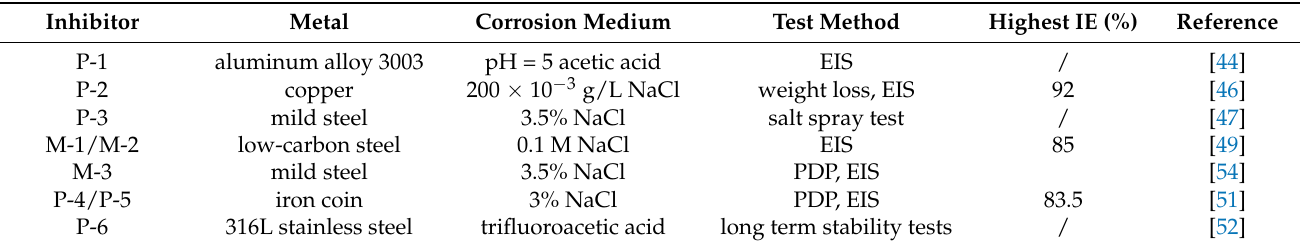
Table 2. Inhibition property of typical phosphorus-containing synthetic polymeric